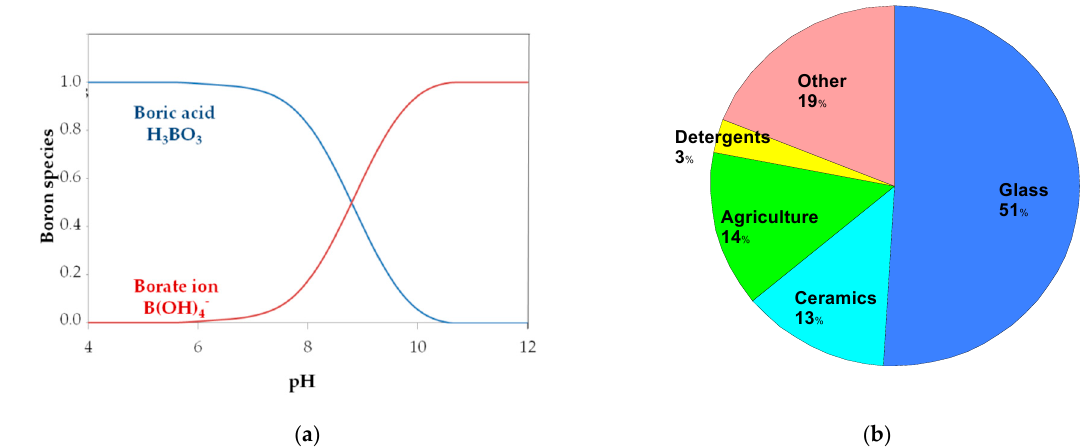
Figure 1. ( a ) The distribution of two dominant forms of inorganic boron in natural aqueous systems versus pH [26], ( b ) global boron end-use share by application [30].